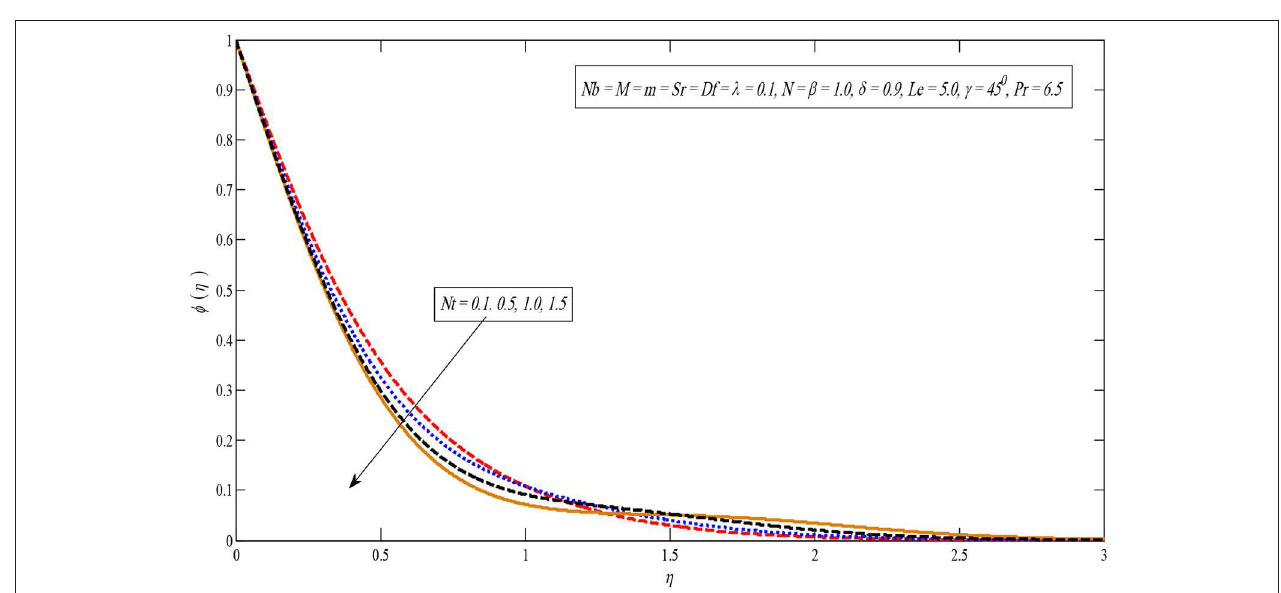
FIGURE 11 | Concentration profile for several values of Nt